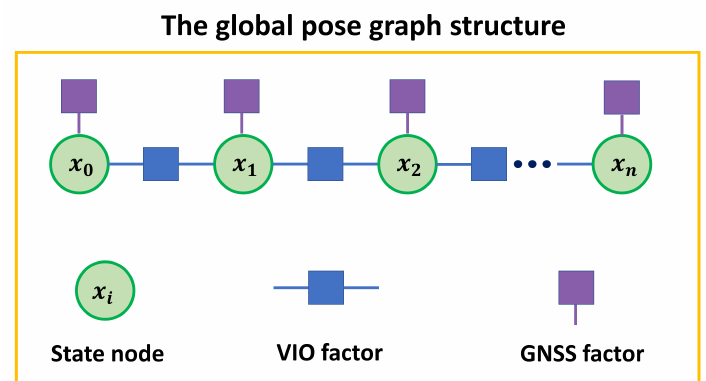
Figure 4. The global pose structure of